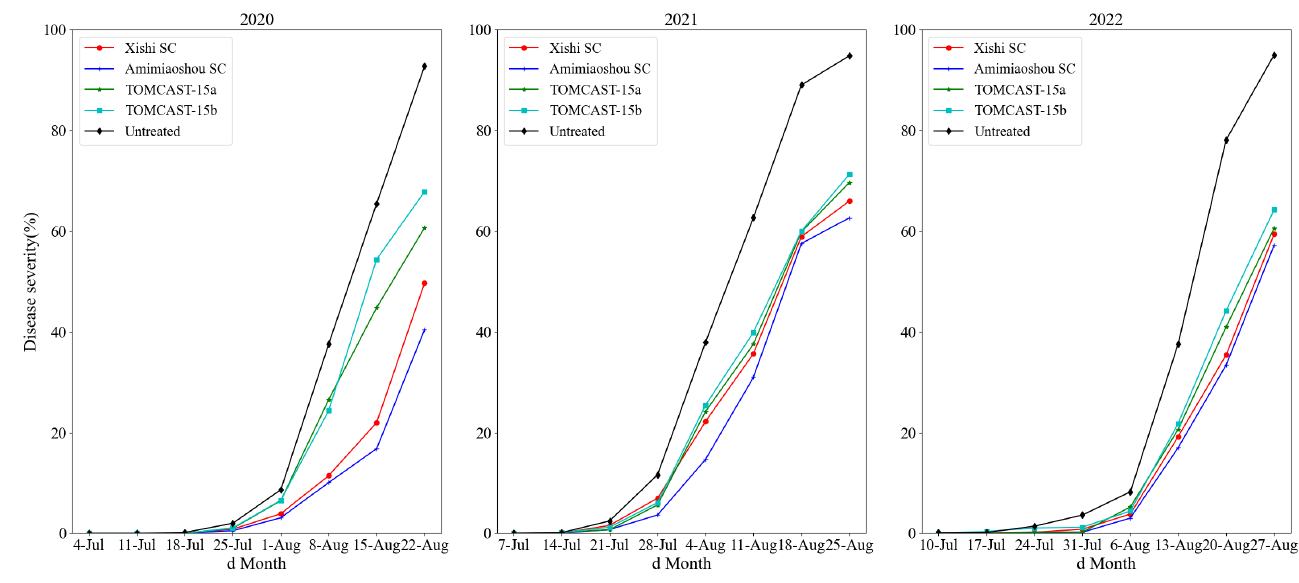
Figure 2. The disease progression of early blight as a function of the different fungicide treatment schedules from 2020 to 2022.